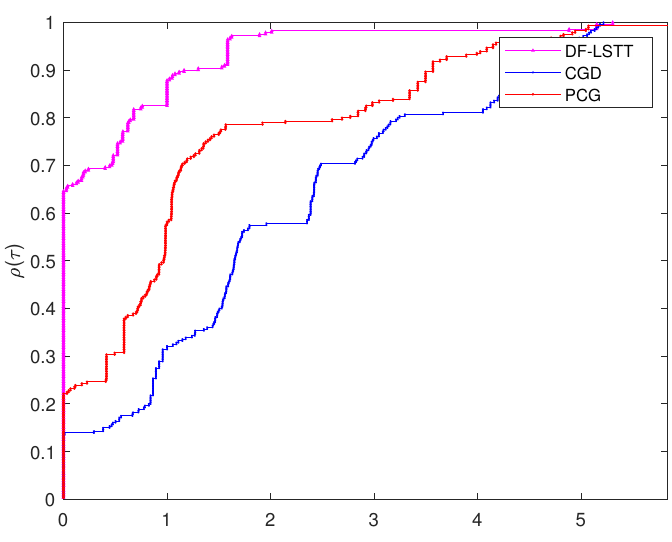
Figure 7. Performance of compared methods relative to the number of function evaluations. Table 3. Numerical test reports for the three tested methods for Problem